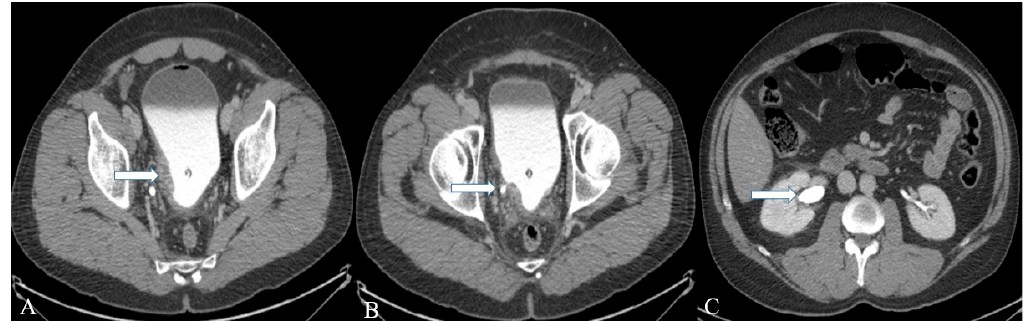
Figure 9. A 32-year-old female with urinary bladder NEN. Axial CT post-contrast ( A ) shows soft tissue thickening (arrow) mounting to mass formation involving the right lateral and posterior urinary bladder wall. ( B , C ) It is seen narrowing (arrow in ( B )) the right ureterovesical junction with secondary mild right hydroureteronephrosis (arrow in ( C )). This mass seems to infiltrate the perivesical fat. A catheter balloon is seen within the bladder lumen. Pathology of the group revealed urothelial carcinoma with neuroendocrine features and focal glandular differentiation, high grade.